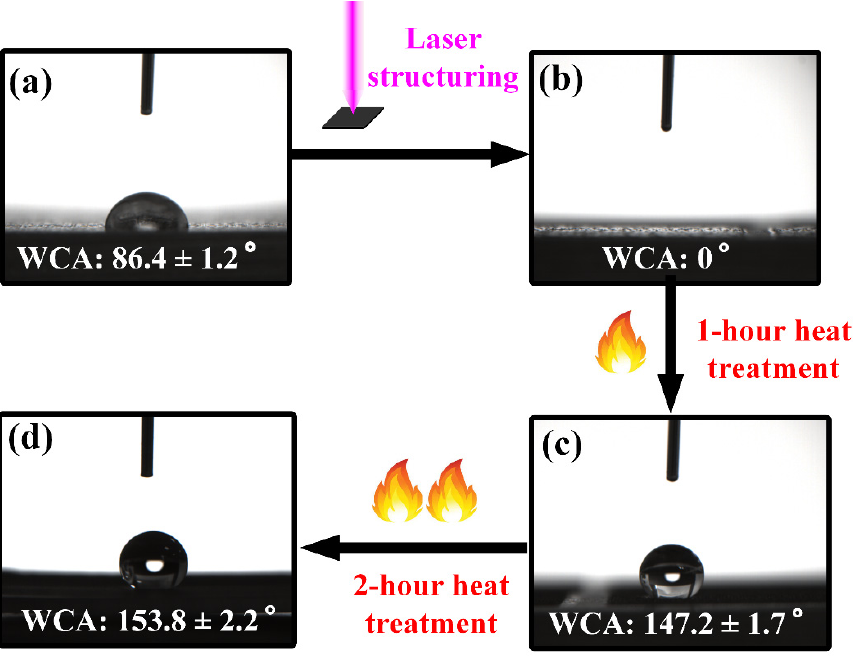
Figure 6. Surface wettability transition of the BMG surface after different treatment steps: ( a ) un- treated; ( b ) upon laser structuring; ( c ) 1 h heat treatment after laser structuring; ( d ) 2 h heat treatment after laser structuring.